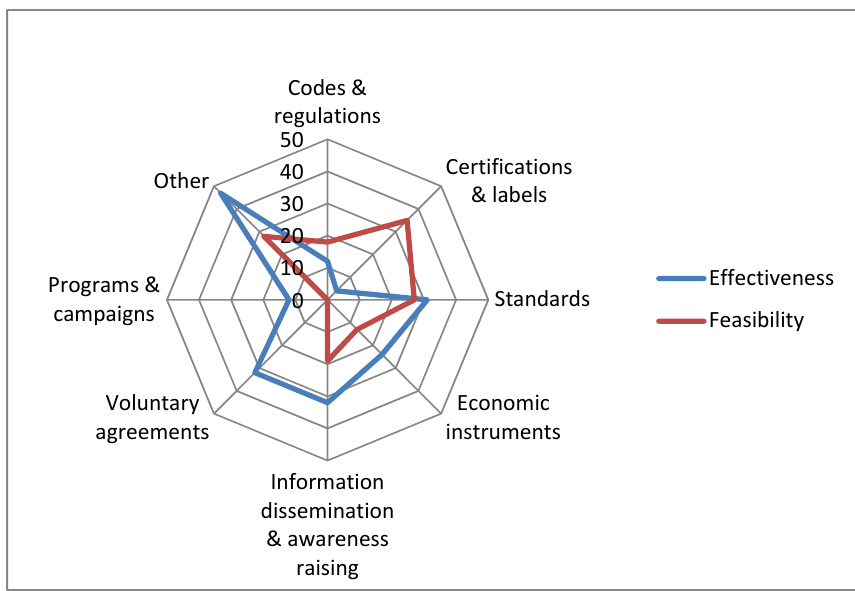
Figure 7. Evaluations of the effectiveness and feasibility of the instruments.